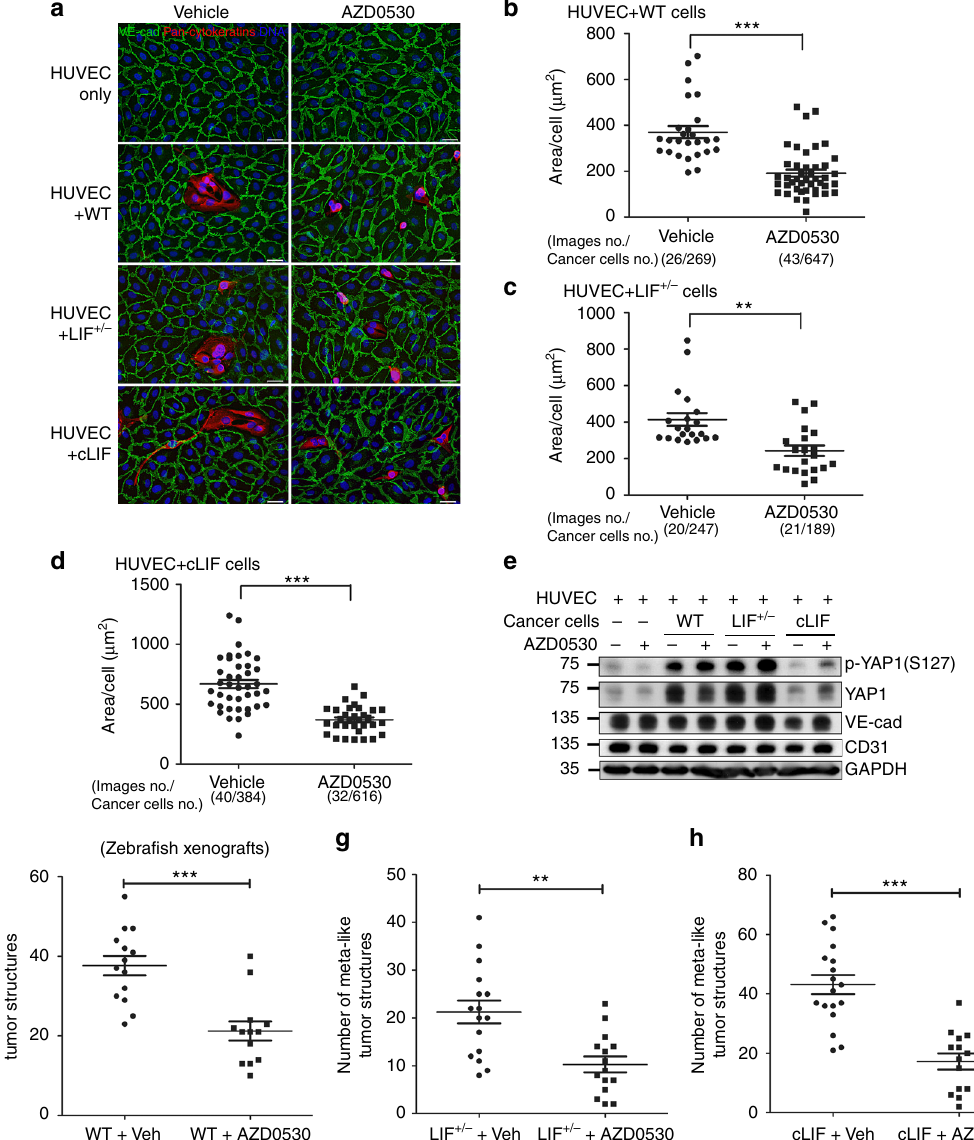
Fig. 8 AZD0530 treatment suppresses cancer vascular dissemination. a HUVEC layer replacement assay. Equal numbers of cancer cells were co-cultivated with con fl uent HUVEC cells for 24 h in the presence of AZD0530 (5 μ m) or vehicle (DMSO). Cells were fi xed and labeled with antibodies against pan- cytokeratin (red) and VE-cadherin (green). Scale bars, 20 μ m. Blue, nuclear staining. b – d Quanti fi cation of displaced areas described in a . HUVEC + WT cancer cells ( b ). HUVEC + LIF + / − cancer cells ( c ). HUVEC + cLIF cancer cells ( d ). Invaded areas were calculated using CellSens imaging software (Olympus). Data are presented with scatter dot plot (mean ± SEM). Each black dot represents one captured image. ** p < 0.01, *** p < 0.001, Mann – Whitney test. e Western blot analysis of p-YAP, VE-cadherin, and CD31 expression in co-cultivated cancer cells and HUVEC cells, as described in a . Total protein lysates were harvested 24 h post AZD0530 treatment using GAPDH as a loading control. f – h Quanti fi cation of disseminated tumor-like structures in zebra fi sh embryonic xenograft models. WT xenografts ( f ). LIF + / − xenografts ( g ). cLIF xenografts ( h ). The number of disseminated tumor-like structures was determined on day 4 after treatment with AZD0530 (15 μ m) or vehicle (DMSO). Data are presented with scatter dot plot (mean ± SEM). Each black dot represents one fi sh embryo. ** p < 0.01, *** p < 0.001, Mann – Whitney